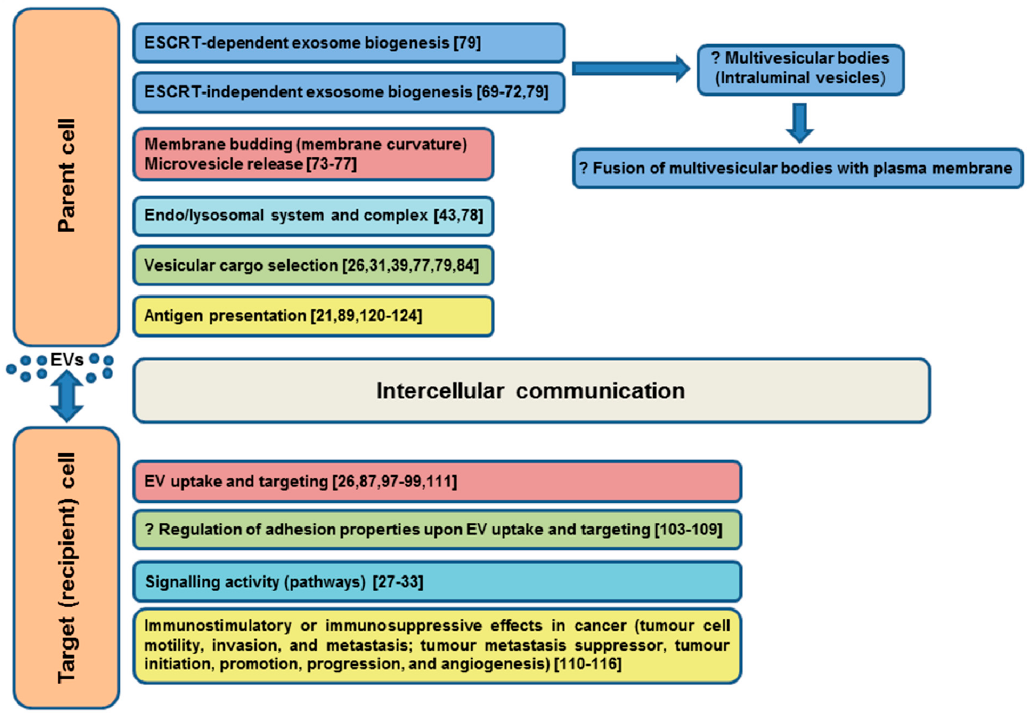
Figure 3. Evidenced/predicted involvement of tetraspanins in EV functions in somatic cells. Figure 3. Evidenced / predicted involvement of tetraspanins in EV functions in somatic cells. EVs-extracellular vesicles, ESCRT—endosomal sorting complex required for transport; ?—predicted EVs-extracellular vesicles, ESCRT-endosomal sorting complex required for transport; ?-predicted role.